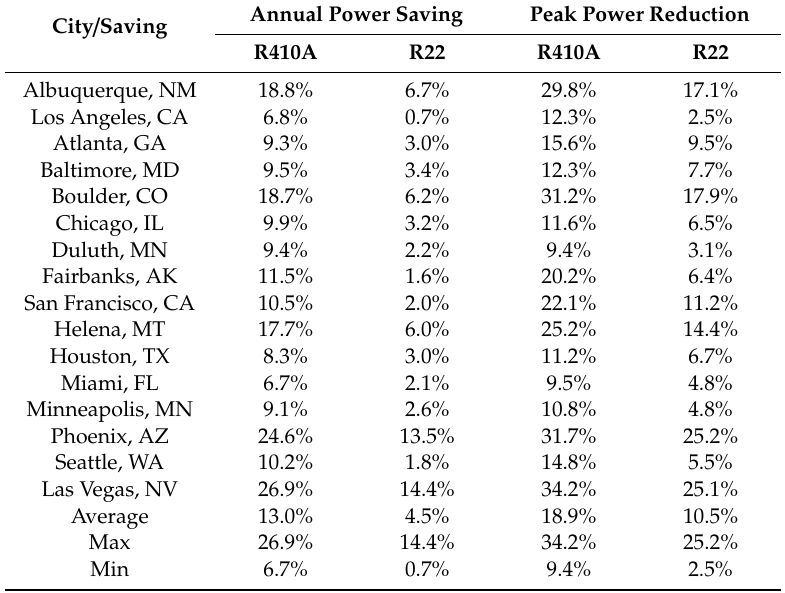
Table 3. Secondary school building: Annual energy savings and peak power